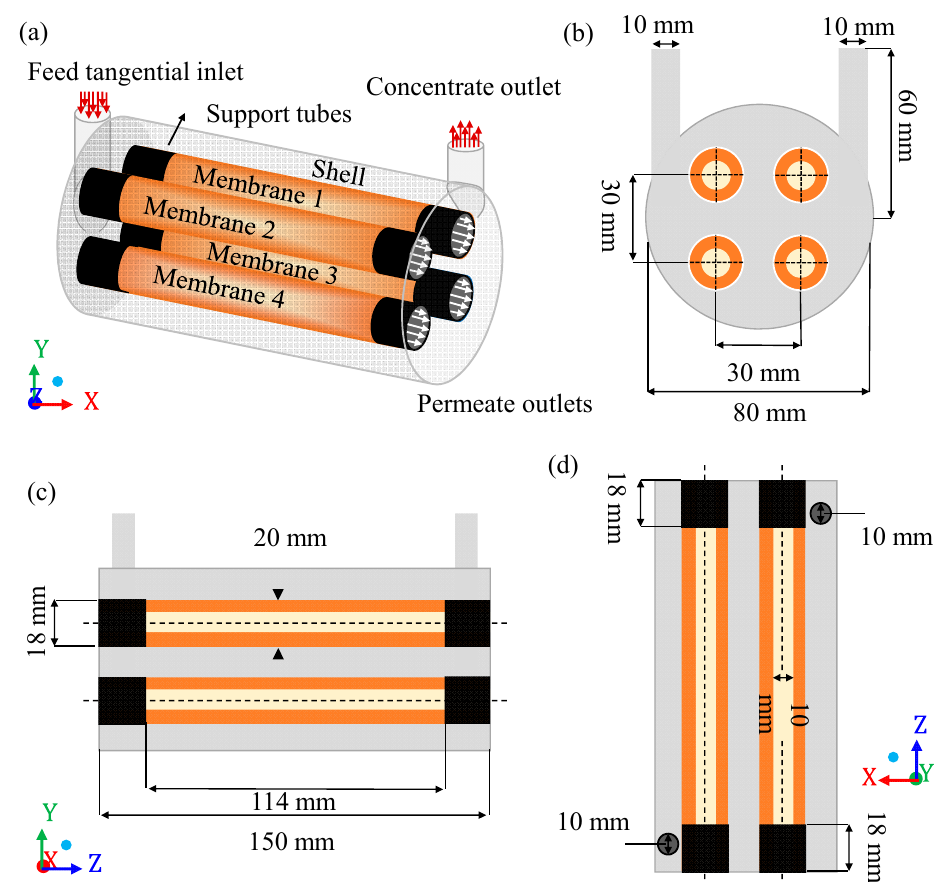
Figure 1. Geometric representation of the module under study ( a ); front view of the separator ( b ); side view of the separator ( c ), and top view of the separator ( d ). Table 1. Geometric dimensions of the shell-tube separation module.